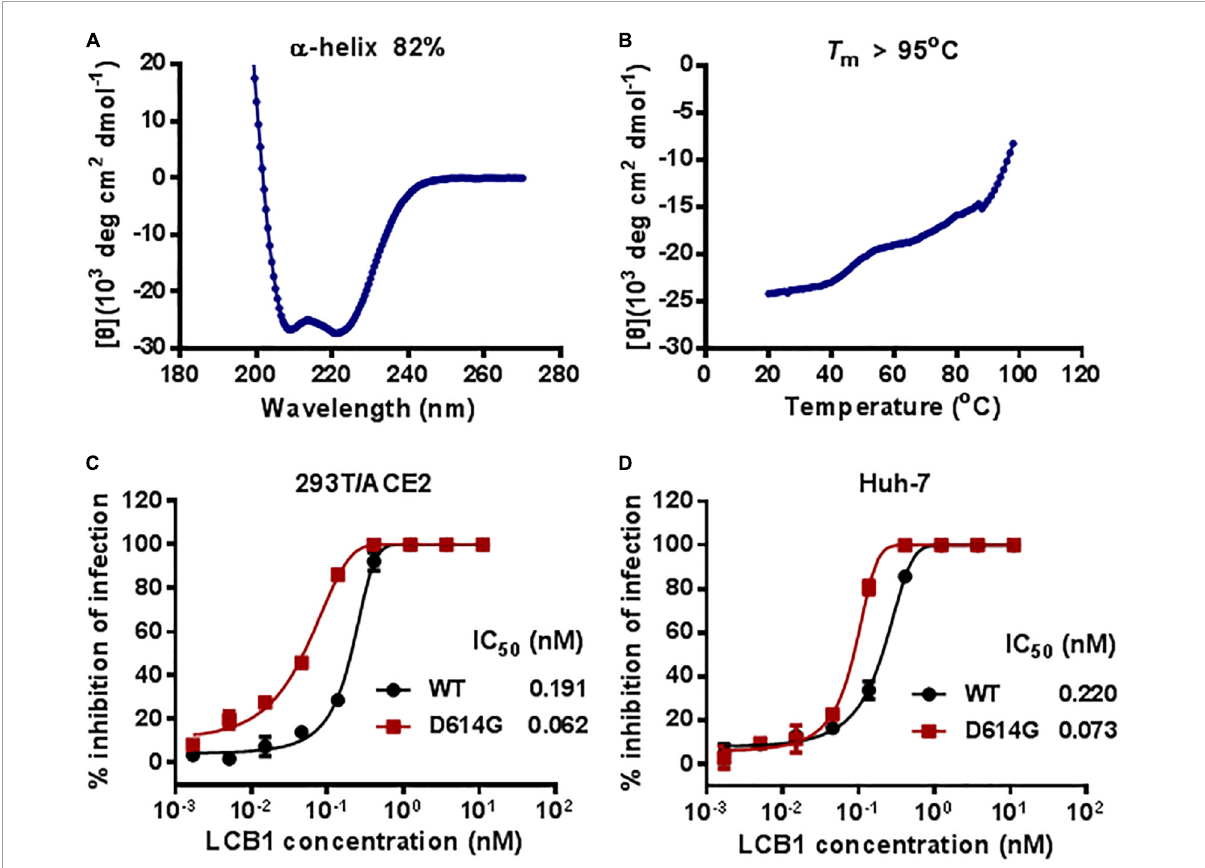
FIGURE1 Structural and functional characterization of LCB1 peptide. The α -helicity (A) and thermostability (B) of LCB1 peptide at a concentration of 20 µ M were determined by Circular dichroism (CD) spectroscopy. The inhibitory activities of LCB1 against infections of wild-type (WT) SARS-CoV-2 and its D614G mutant on 293T/ACE2 cells (C) and Huh-7cells (D) were measured by a single-cycle infection assay. Samples were tested in triplicate and repeated, and data are presented as means.